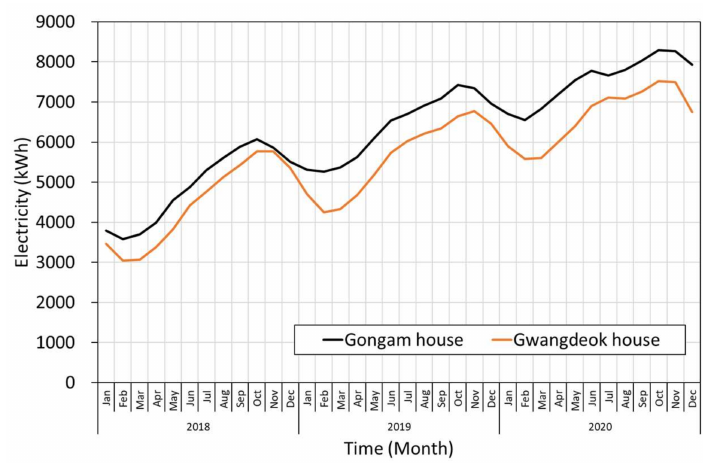
Figure 8. Monthly cumulative surplus